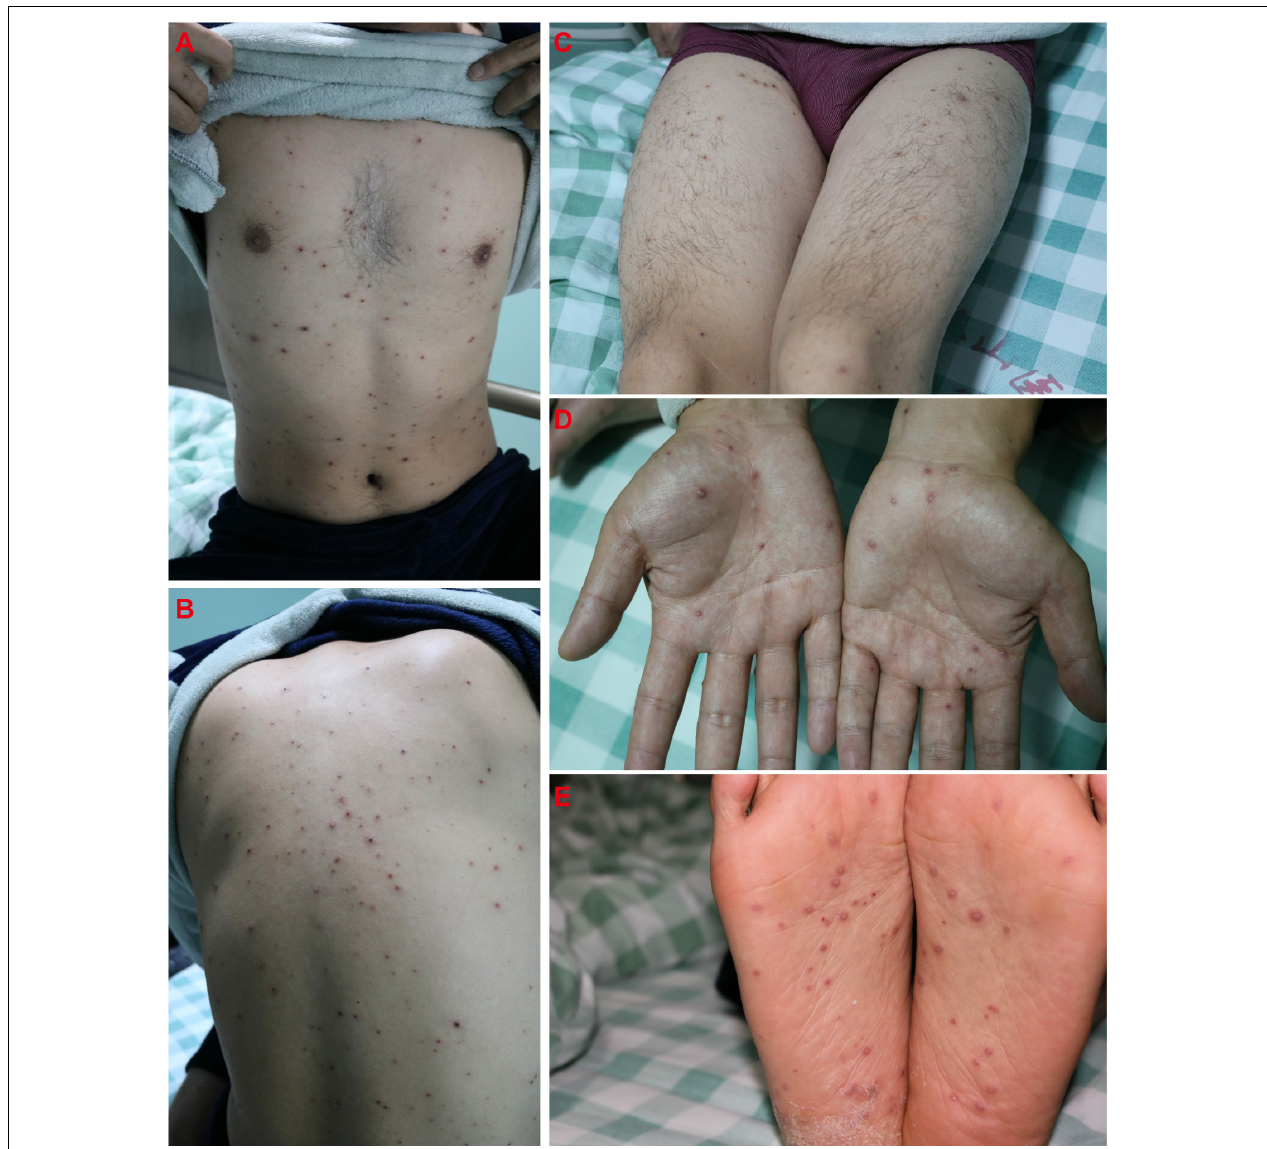
FIGURE 4 | Classic pruritic vesicular rash on trunk (A–C) and extremities (D,E) in the father (Case